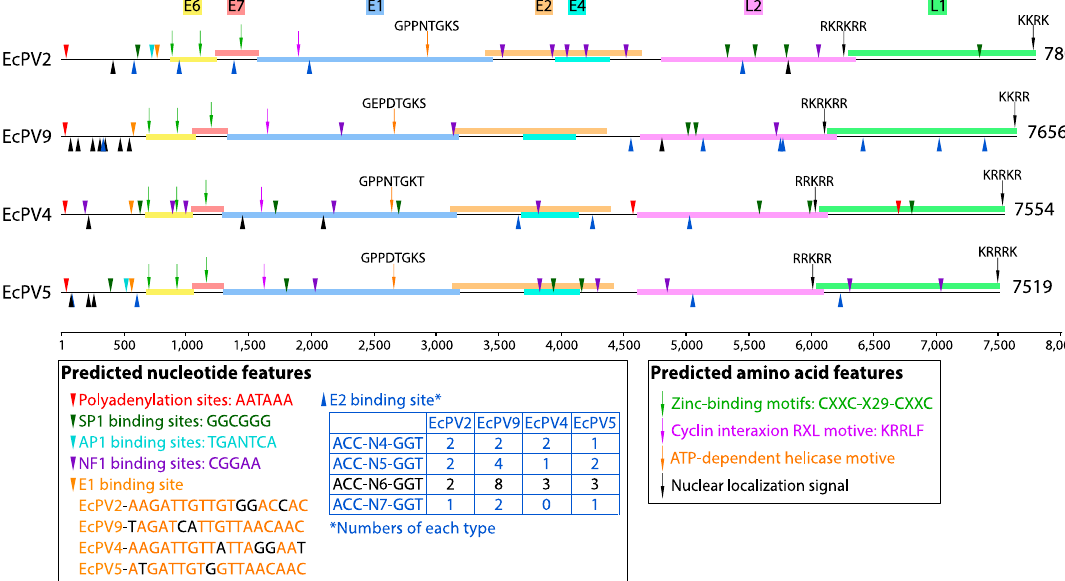
Figure 2. The genome of EcPV9 and three equine papillomaviruses from the genus Dyoiotapapillomavirus . Open reading frames (ORFs) are shown at the top and colored according to their putative function. Predicted nucleotide features are shown above and below each genome, using triangles and colored according to different features. Predicted amino acid features are shown above each genome, using down arrows and colored according to the feature in question. Sequences of E1 binding sites are shown in the left box at the bottom with variable nucleotides shown in black type. True consensus E2 binding sites (ACC-N6-GGT) are colored black, while other putative E2 binding sites (ACC-N4-GGT, ACC-N5-GGT, ACC-N7-GGT) are shown in blue, and the numbers of E2 binding sites within each papillomavirus are shown in the left bottom box. Sequences of the ATP-dependent helicase motive and nuclear localization signal are shown above each arrow.